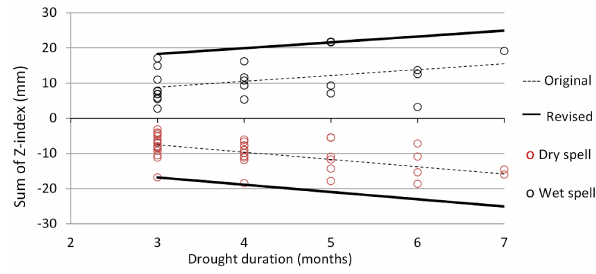
Figure A1. Accumulated z-index (mm) versus duration (months) with the intercept of the most extreme drought/wet